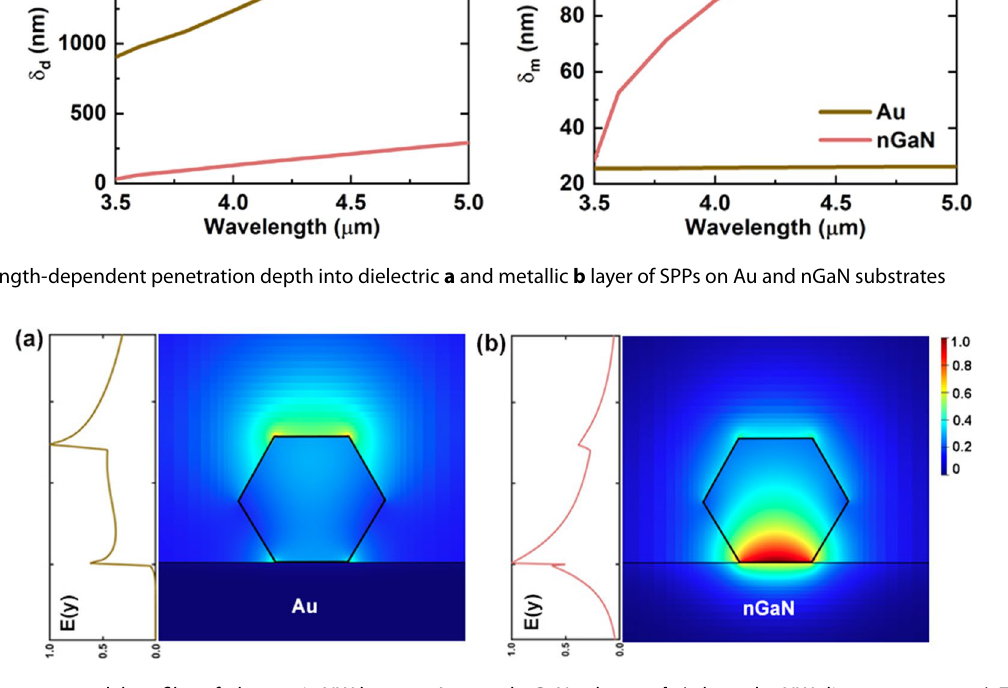
Fig. 4 The transverse modal profiles of plasmonic NW laser on Au a and nGaN substrate b (where the NW diameter = 500 nm). The inset on the left shows the normalized electric field distribution along